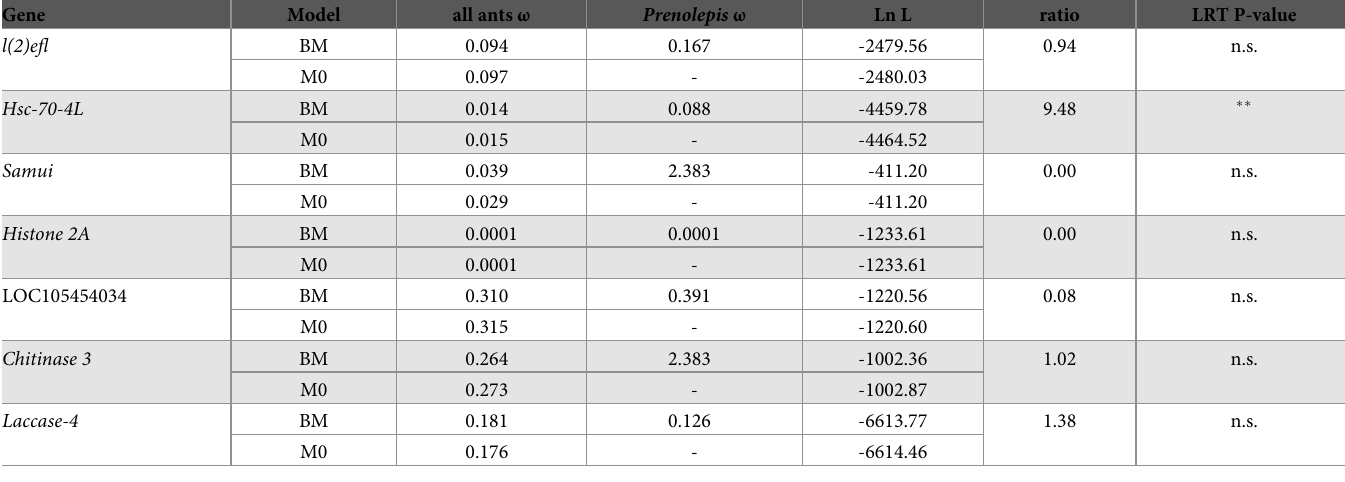
Table 3. Likelihood ratio test evaluating signals of positive selection along the Prenolepis branch.